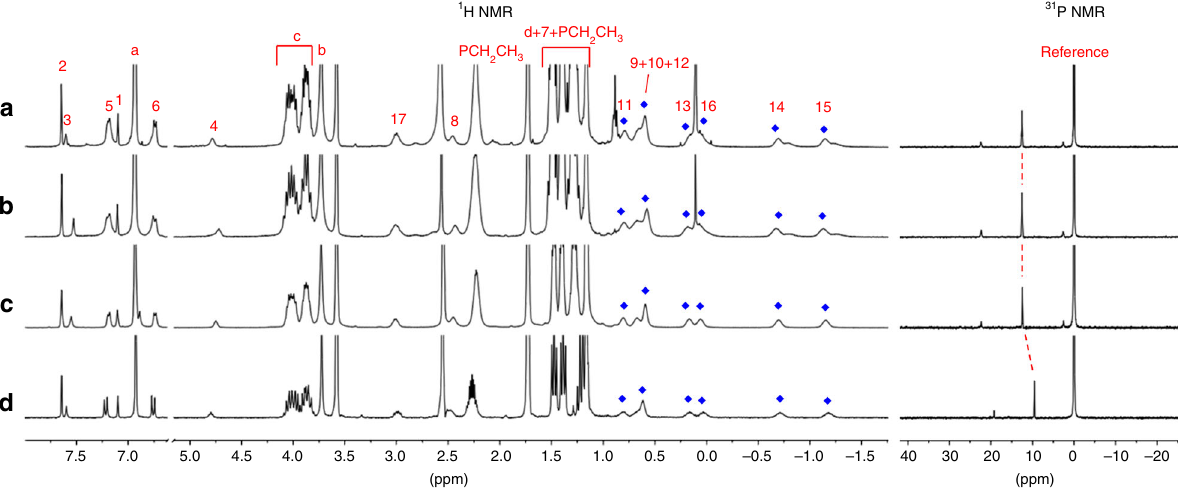
Fig. 4 Partial 1 H NMR (THF- d 8 , 298 K, 400 MHz) and 31 P NMR (THF- d 8 , 298 K, 122 MHz) spectra of a rotaxane-branched dendrimer G 3 ; b rotaxane- branched dendrimer G 2 ; c rotaxane-branched dendrimer G 1 ; d [2]rotaxane